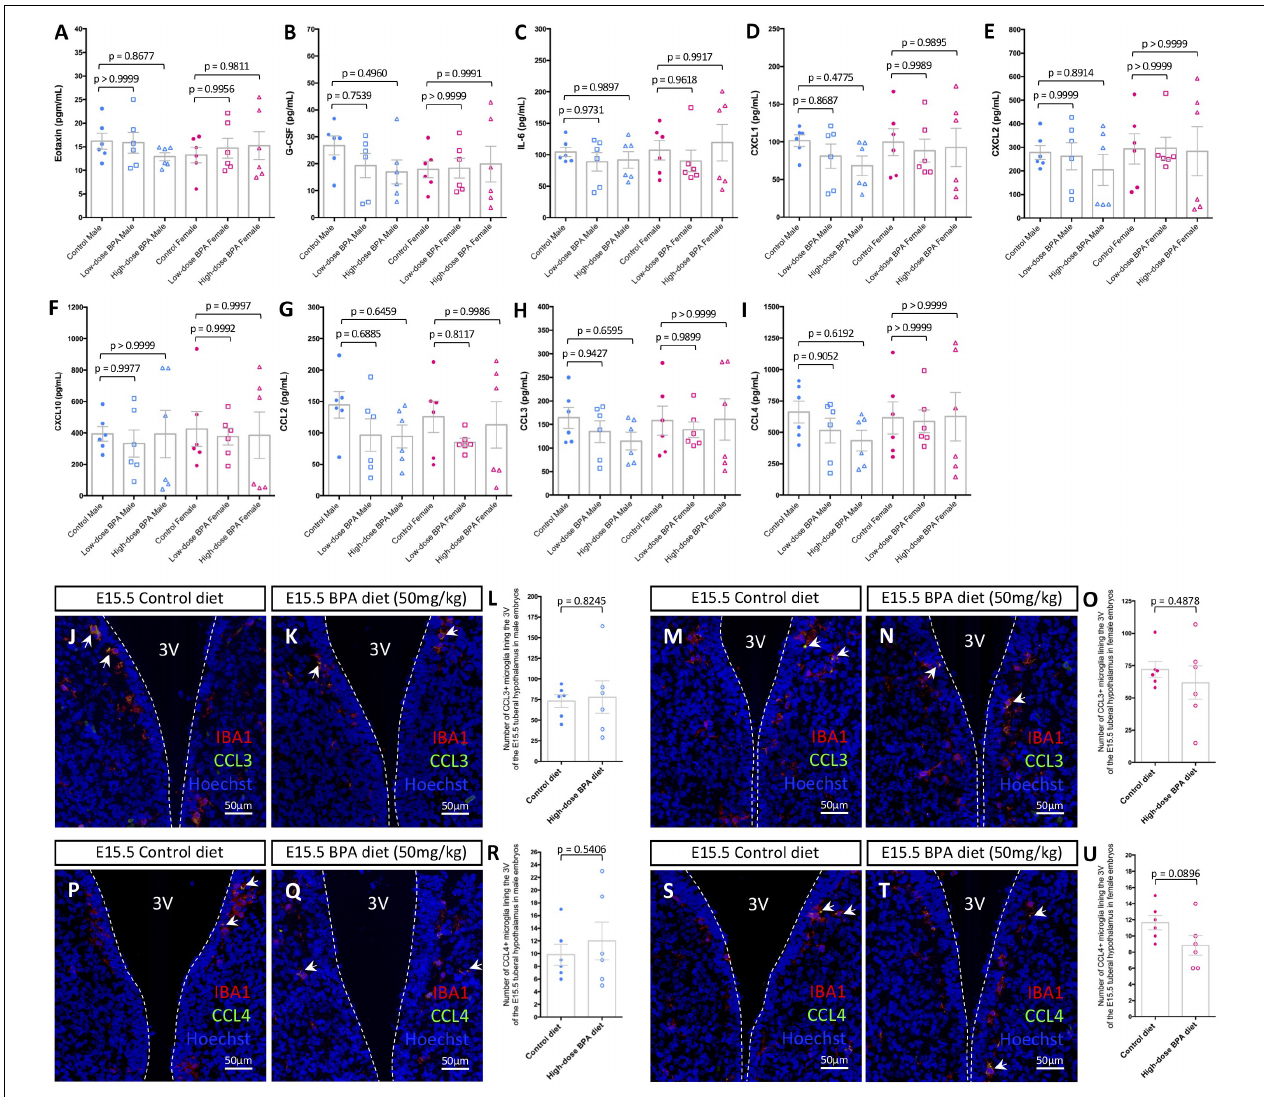
FIGURE 2 | Gestational BPA exposure does not impact cytokine or chemokine secretion. (A–I) Quantification of Eotaxin (A) , G-CSF (B) , IL-6 (C) , CXCL1 (D) , CXCL2 (E) , CXCL10 (F) , CCL2 (G) , CCL3 (H) , and CCL4 (I) secretion levels (pg/mL) from cultured control, low dose (50 µ g/kg), and high dose (50 mg/kg) BPA exposed male and female brains ( n = 6). (J,K) IBA1, CCL3, and Hoechst staining in the E15.5 tuberal hypothalamus of control (J) and BPA exposed (K) male embryos. (L) Quantification of the number of CCL3/IBA1 double-positive microglia in the E15.5 tuberal hypothalamus of control and BPA exposed male embryos ( n = 6; p = 0.8245). (M,N) IBA1, CCL3, and Hoechst staining in the E15.5 tuberal hypothalamus of control (M) and BPA exposed (N) female embryos. (O) Quantification of the number of CCL3/IBA1 double-positive microglia in the E15.5 tuberal hypothalamus of control and BPA exposed female embryos ( n = 6; p = 0.4878). (P,Q) IBA1, CCL4, and Hoechst staining in the E15.5 tuberal hypothalamus of control (P) and BPA exposed (Q) male embryos. (R) Quantification of the number of CCL4/IBA1 double-positive microglia in the E15.5 tuberal hypothalamus of control and BPA exposed male embryos ( n = 6; p = 0.5406). (S,T) IBA1, CCL4, and Hoechst staining in the E15.5 tuberal hypothalamus of control (S) and BPA exposed (T) female embryos. (U) Quantification of the number of CCL4/IBA1 double-positive microglia in the E15.5 tuberal hypothalamus of control and BPA exposed female embryos ( n = 6; p = 0.0896). (J,K,M,N,P,Q,S,T) White arrows point to microglia. White dashed lines mark the third ventricle (3V). (A–I,L,O,R,U) Counts represent means ± SEM and were analyzed by a two-way ANOVA with Tukey’s post hoc analysis (A–I) or by a Student’s t -test (L,O,R,U) .